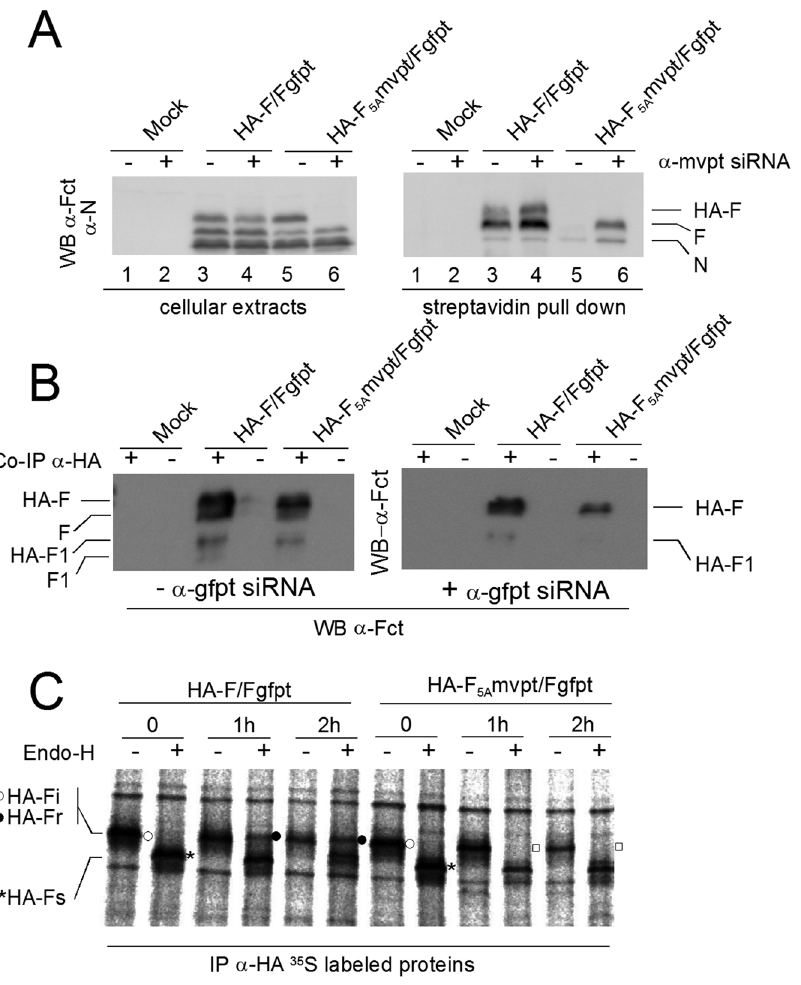
Figure 5. Biochemical characterization of the HA-F 5A protein. A . BSRT7 cells expressing or not a -mvpt siRNA ( + / 2 ) were infected with the indicated viruses. At 24 hours post infection, cells were biotinylated in situ and a fraction of cellular extracts was analysed directly by Western blotting (left panel). The remaining was submitted to streptavidine bead pull down before analysis (right panel). Western blots were probed with a -Fct and a - N. B . Infections of MDCK cells, expressing or not a -gfpt siRNA. Forty hours post infection total cell immunoprecipitations were performed using or not a -HA antibodies ( + / 2 ). Immune-precipitates were analysed by Western blot using a -Fct. Cellular inputs of this experiment can be seen in figure S5. C . Infections of MDCK cells expressing a -gfpt siRNA were performed with the indicated viruses. Sixteen hours post infection, the infected cells were pulse-chase radiolabelled. HA-F proteins were immunoprecipitated using a -HA and then treated or with Endo-H (Endo-H, + / 2 ). Digested samples N were analysed by PAGE and detected by autoradiography. HA-Fi ( # ): initial HA-F recovered at the end of the pulse and not treated with Endo-H. HA- ): resistant to Endo-H and ( % ): shows lack of resistant HA-F 5A . Fs (*): sensitive to Endo-H digestion. HA-Fr (